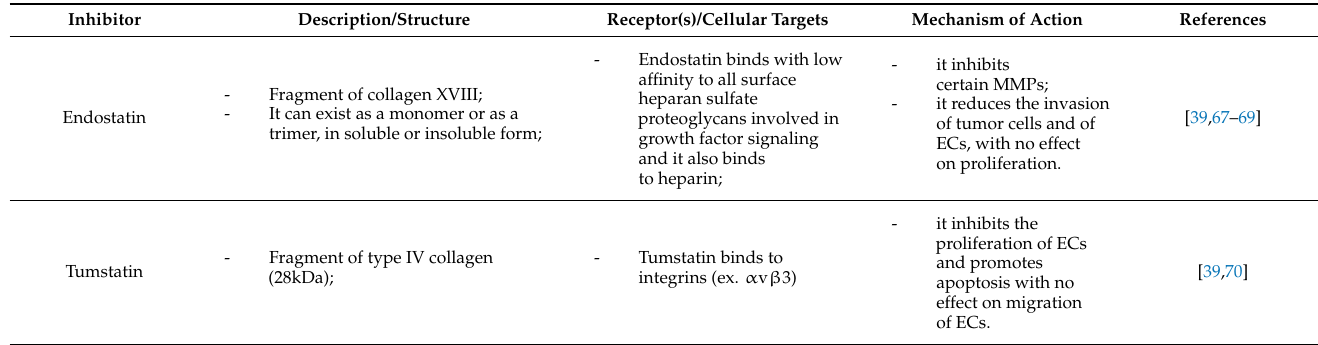
Table 2. Endogenous Angiogenesis